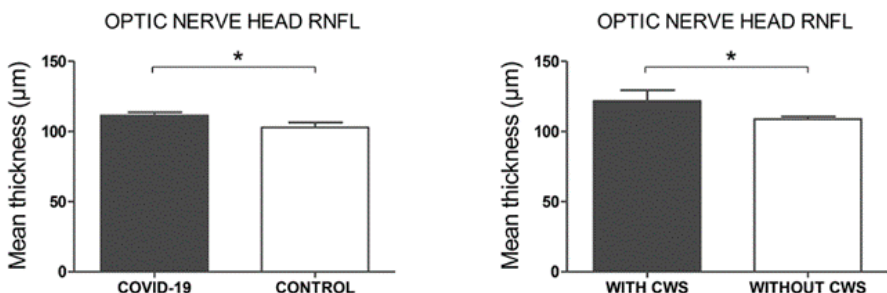
Figure 3. Structural optical coherence tomography (OCT) analysis, macula. Mean foveal thickness glion cell layer (GCL), and choroid layers. p -values correspond to a comparison between COVID-